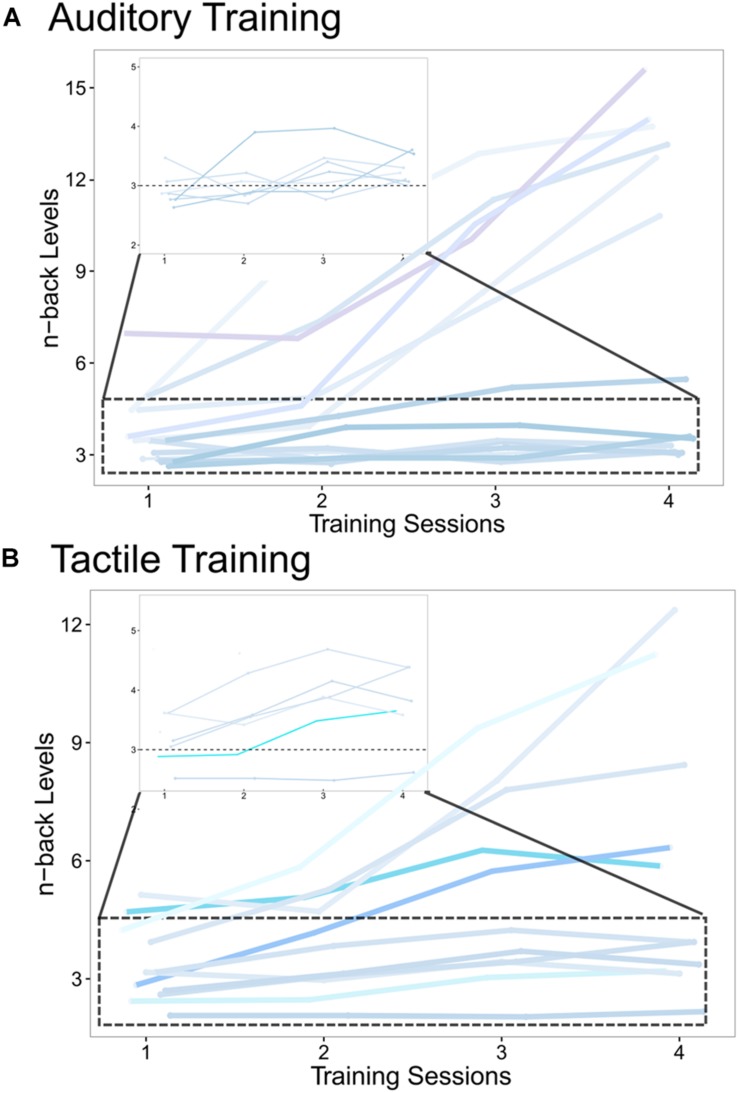
Individual training tracks measured during the 4 training sessions of (A) the auditory training group and (B) the tactile training group. The individual courses (blue color-coding) of n-back levels, averaged over 30 blocks per training session, are shown for all four training sessions, demonstrating the growing WM capacity with training progress. The zoomed in area (dotted box) shows participants with more moderate n-back increases. The horizontal dotted line at 3-back level serves as a guide to highlight capacity increases.